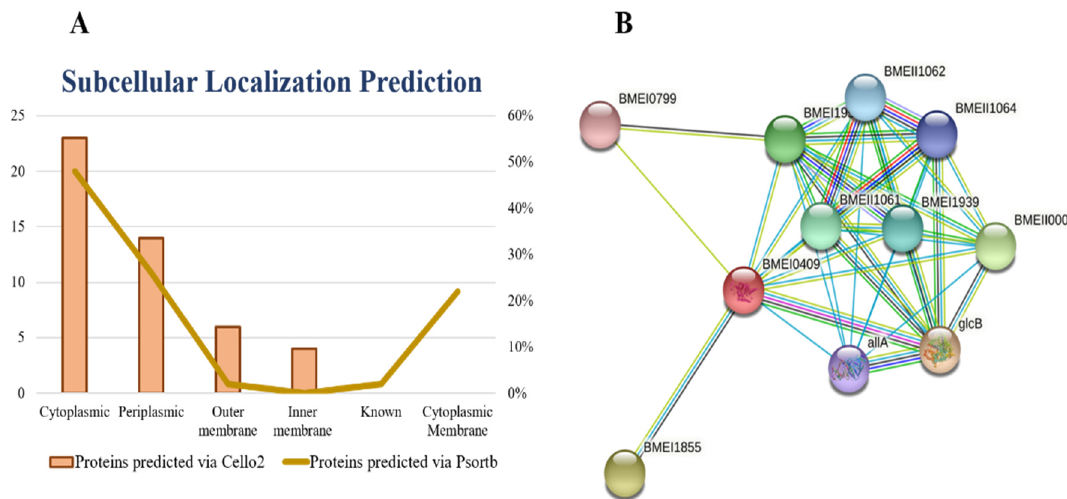
Figure 2. Subcellular localization and PPI. ( A ) Quantitative representation of subcellular localization of shortlisted essential, druggable, pathogen-specific proteins predicted through PSORTb, and Cello2 and ( B ) Protein–protein interaction analysis for ICL. The STRING results showed different interactions of proteins with each other represented by nodes and edges. The number of nodes represents proteins such as splice isoforms and post-translational modified proteins. Each node represents a specific protein encoded by a single gene. The color of nodes explains the protein interaction as first shell interactors and query protein are represented by colored nodes while the second shell interactors are represented by white nodes.